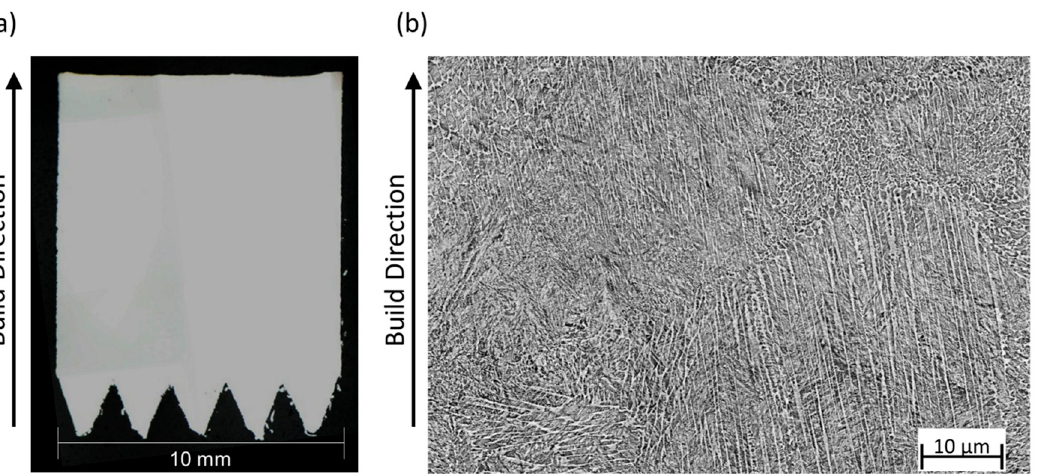
Figure 4. Crack density vs. Energy density.